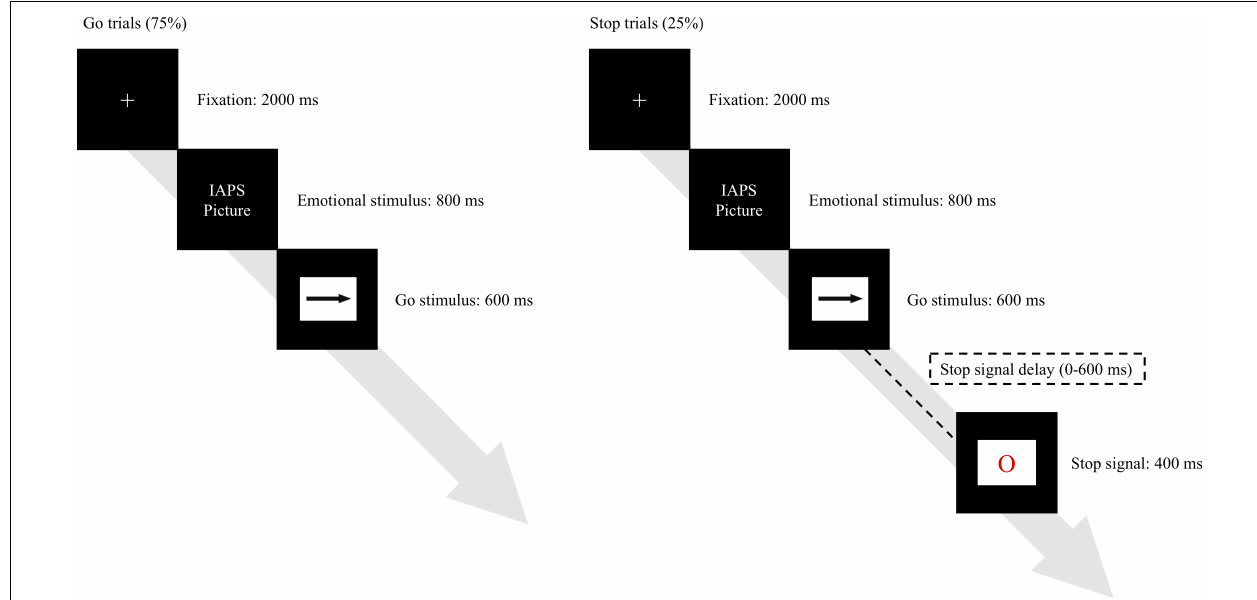
FIGURE 1 | The procedure of emotional stop signal